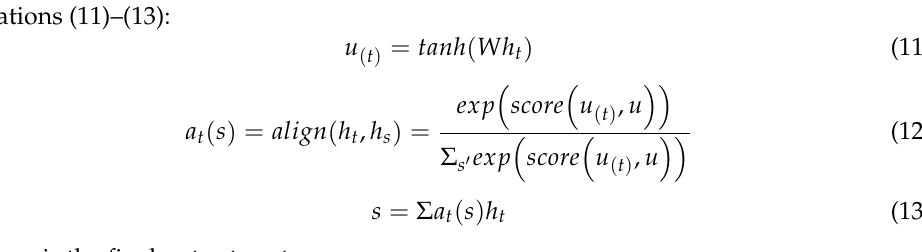
Figure 4. The overall process from input to output. By calculating MFCC and its first-order and second-order differentials, and by stack- ing them together, a three-channel color picture (64 × 64 × 3) with transverse length related to signal duration and longitudinal length related to filter bank, is obtained, which is the input layer of the network. The Python speech-feature built-in functions were used to ex- tract the above three features. For network parameter settings, see Table 1: Table 1. The network parameter Settings. Layers